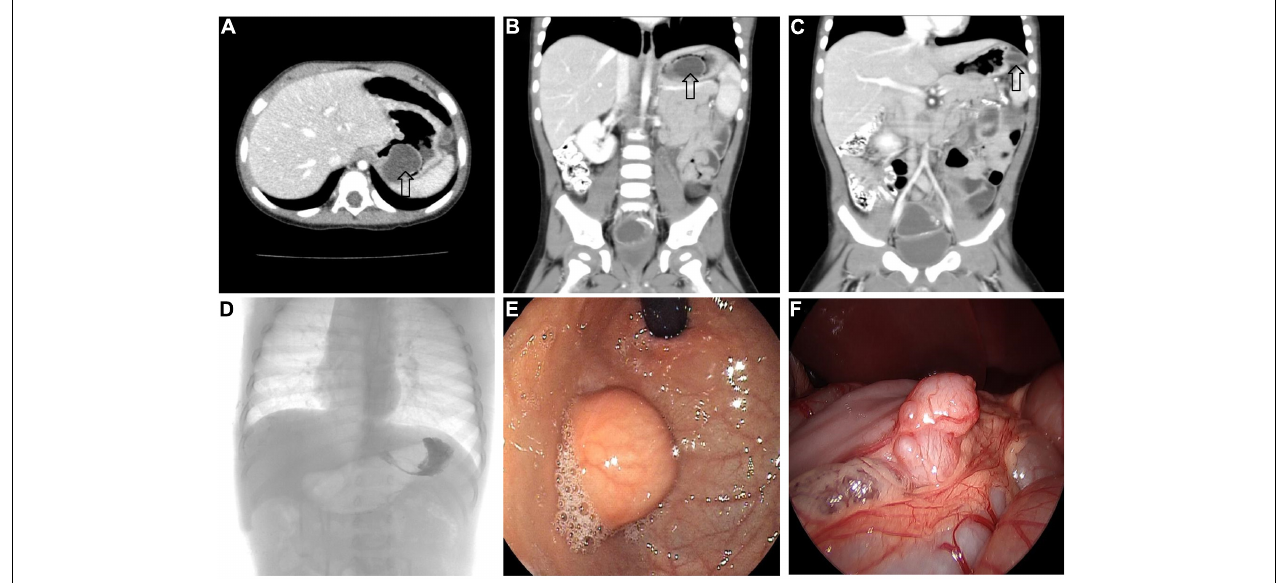
FIGURE 3 | Multiple GDs (arrow) in a 1-year-old boy. (A–C) CT showed GDs located at the gastric funds and greater curvature. (D) Upper gastrointestinal radiography showed filling defect in the gastric funds. (E) Gastroscope found a spherical mass at the gastric fundus with a smooth surface. (F) An irregular mass can be seen at the great curvature of the stomach under laparoscopy.